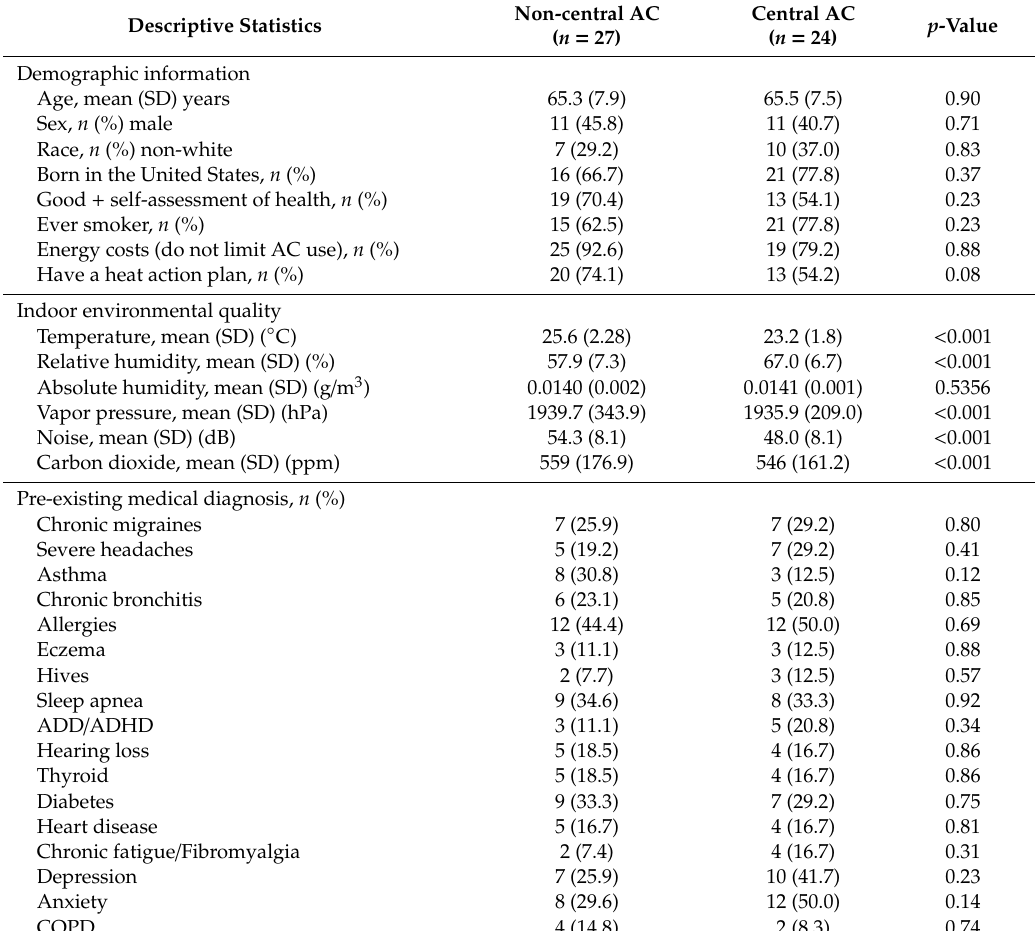
Descriptive statistics for demographics, pre-existing medical diagnoses, and indoor environmental quality of study participants living in public housing with and without central air conditioning (AC) in Cambridge,